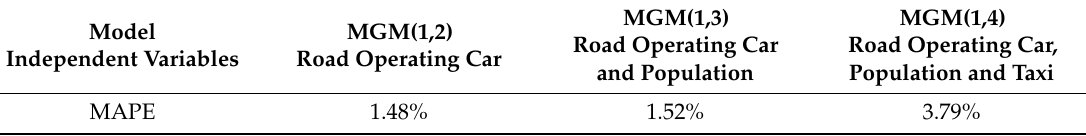
Table 3. Evaluation results of di ff erent MGM(1,N) models with various independent